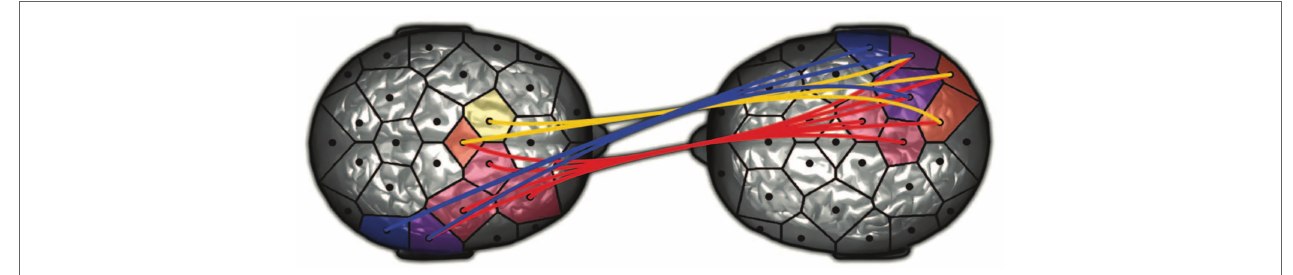
FIGURE 2 | Top-down view of a right-lateralized interbrain synchronization of a co-created spontaneous nonverbal communication system. From “Toward a Two- Body Neuroscience” by Dumas (2011). Permission by